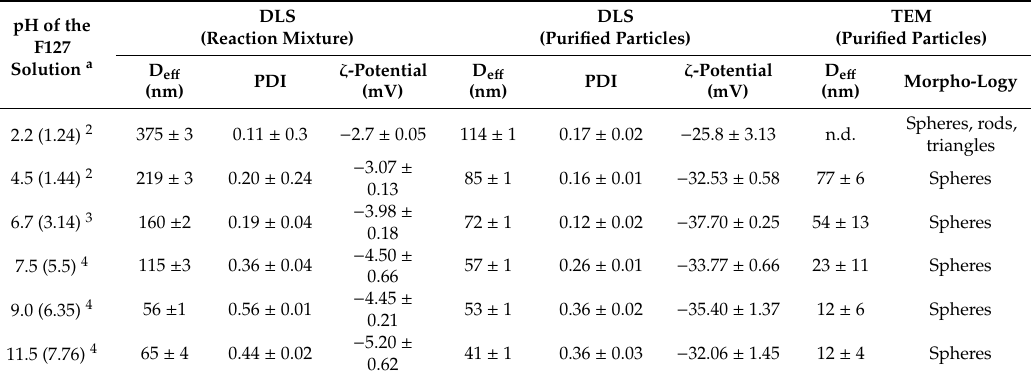
Table 3. E ff ect of pH of F127 solution on the GNP characteristics 1